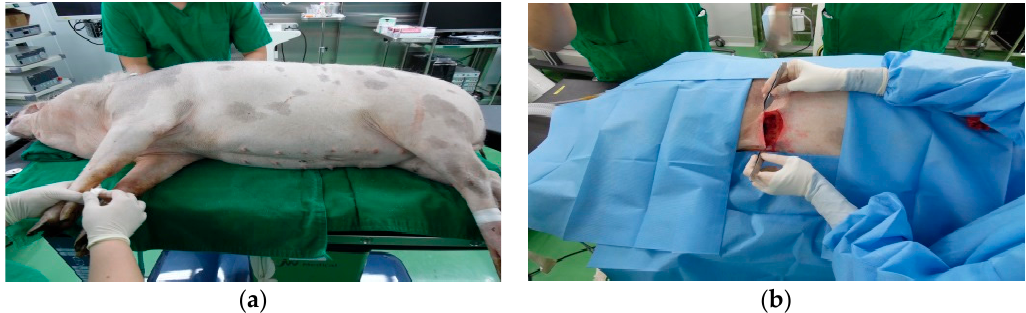
Figure 3. Animal experiment: ( a ) Test animal and ( b ) photograph of implanting the device into subcutaneous fat.